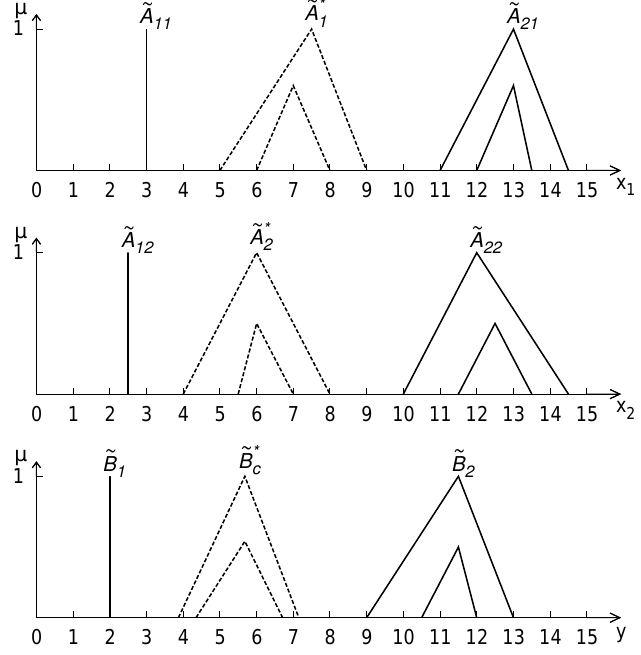
Figure 5. Two multi-antecedent rules interpolation with singleton-valued